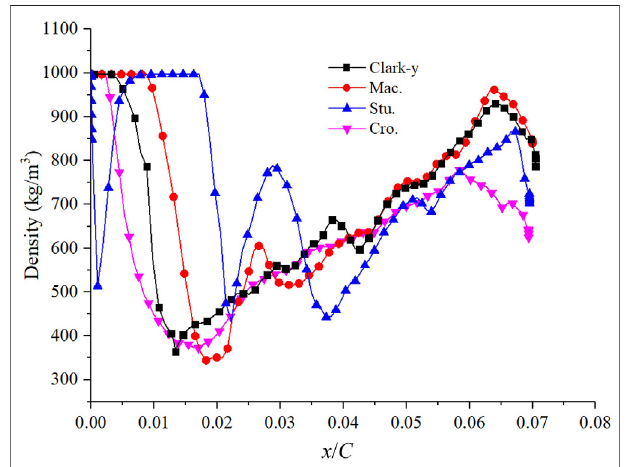
FIGURE 7 | Average density distribution on the suction surface of the four hydrofoils, σ (cid:1) 0 .